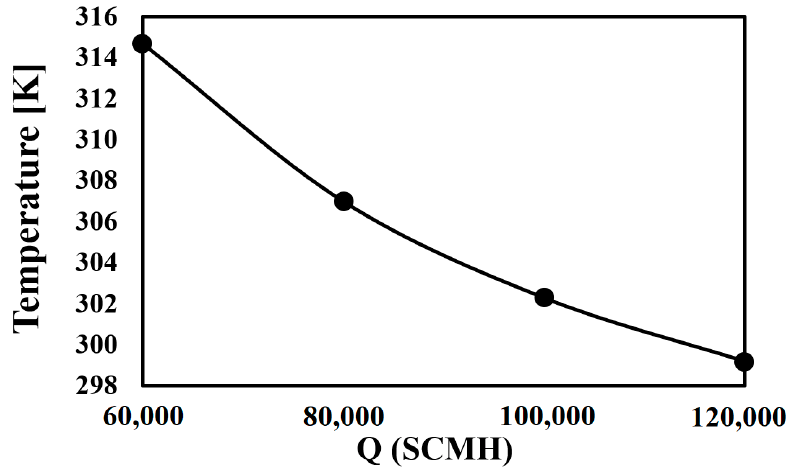
Figure 12. The variation in the coil outlet temperature against the inlet mass flow rate.